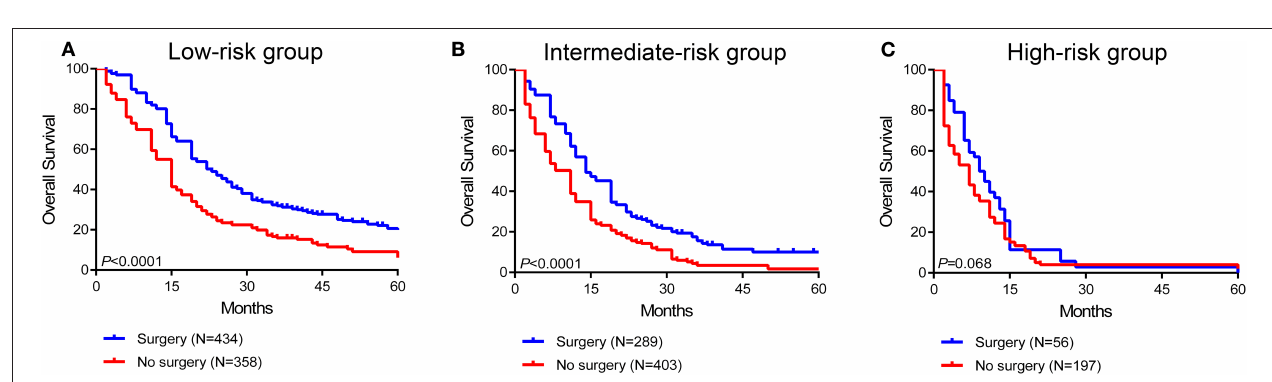
FIGURE 6 | Survival benefit of surgery in the low-risk (A) , intermediate-risk (B) , and high-risk (C) groups.